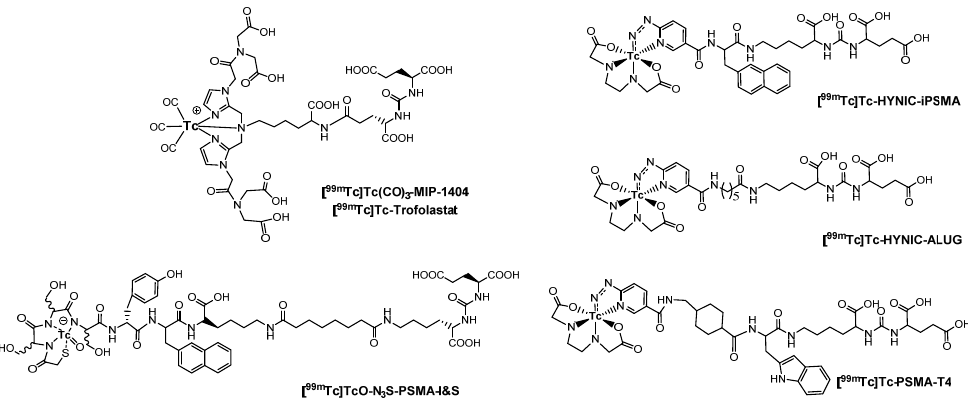
Figure 11. Putative structures of [ 99m Tc]Tc-tagged-PSMA-i under clinical